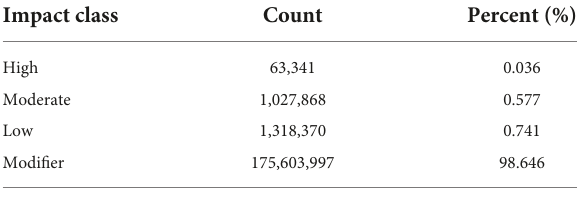
TABLE 1 Effects of the identified SNPs on genes.